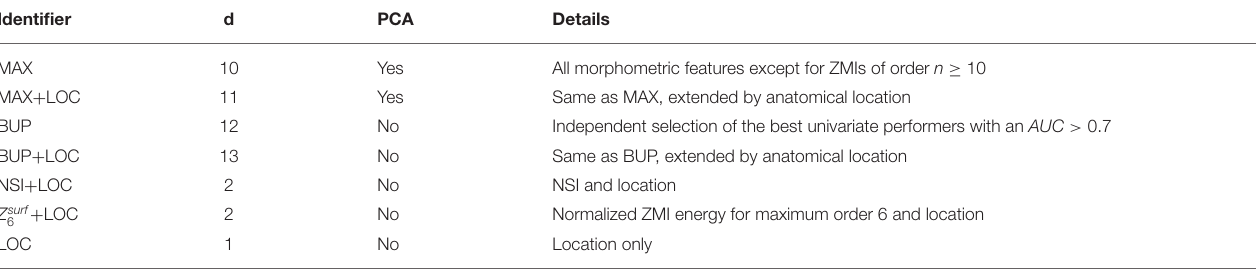
TABLE 4 | Description of multivariate models considered in this study and their number d of predictors. Identifier